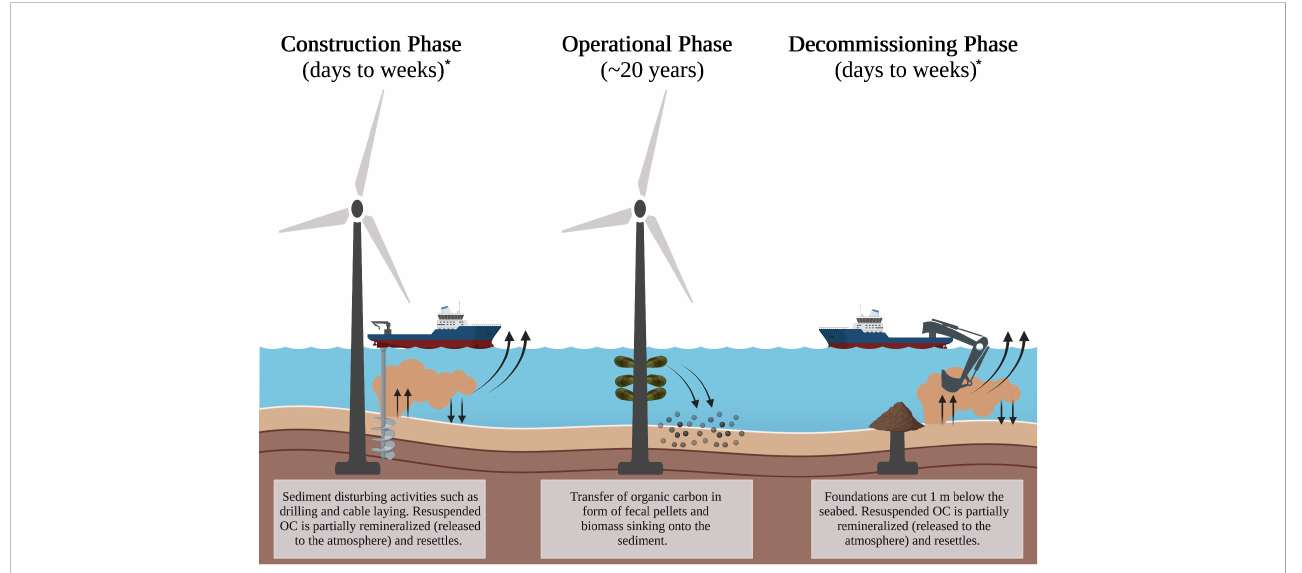
FIGURE 1 Impacts of different life cycles (construction phase, operational phase, decommissioning phase) of OWFs on the sediment and the resulting trapped and released organic carbon (OC) in the upper 1 m of the sediment. *The period refers only to the duration of sediment-disturbing activities of individual elements of OWFs, such as individual cables and individual turbines, and not to time needed to install the entire wind farm or to the duration of all processes involved in construction or decommissioning, i.e. the time for installation of the rotor blades is not considered, for